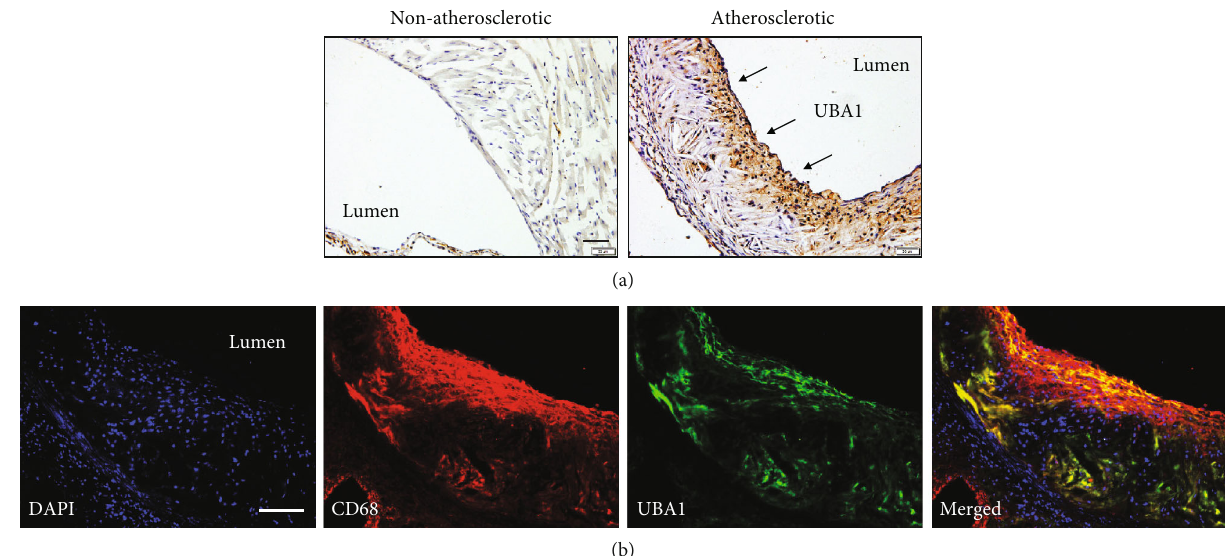
Figure 1: UBA1 expression was upregulated and mainly derived from macrophages in the atherosclerotic plaques of Apoe-/- mice. (a) Expression of UBA1 in the vessels with (right) or without atherosclerotic plaques (left). (b) Colocalization of UBA1 with the macrophage marker CD68 in the atherosclerotic